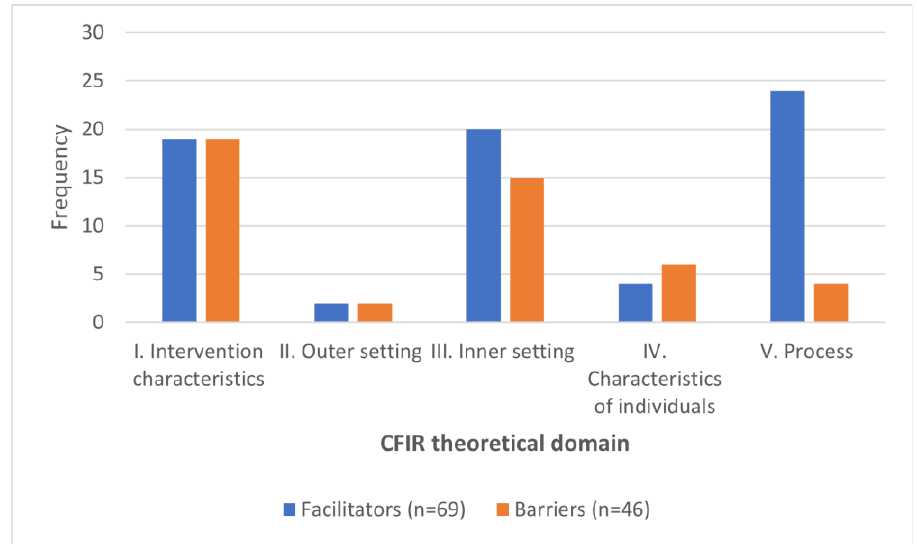
Figure 3. Frequency of facilitators versus barriers.